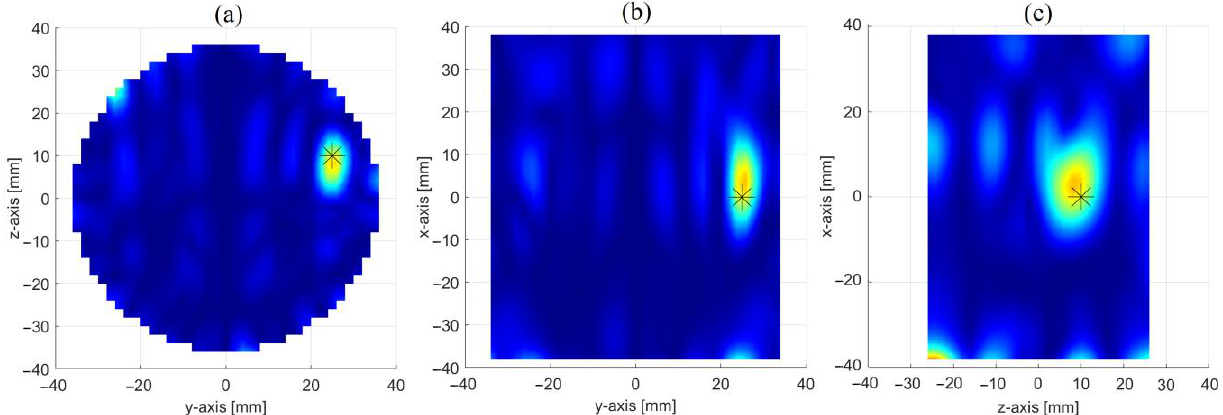
Figure 9. Reconstruction of the inclusion by combining the results of the PSP and the OSP based approaches: images in three orthogonal cut planes crossing the center of the inclusion (stars give the position of the inclusion) i.e., ( a ) x = 0 cm cut plane, ( b ) z = 10 cm cut plane and ( c ) y = 25 cm cut plane.